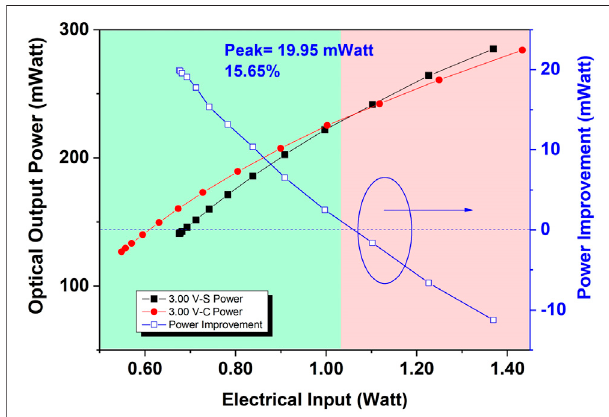
FIGURE3| Thetotalopticaloutputpowerversustotalelectricalinputfor two setups and corresponding power improvement for group A compared to group B. Here, LED-2 is under a voltage of 3.00 V for both groups. V-C is Group A combined LED setup and V-S is Group B Separated- LEDs